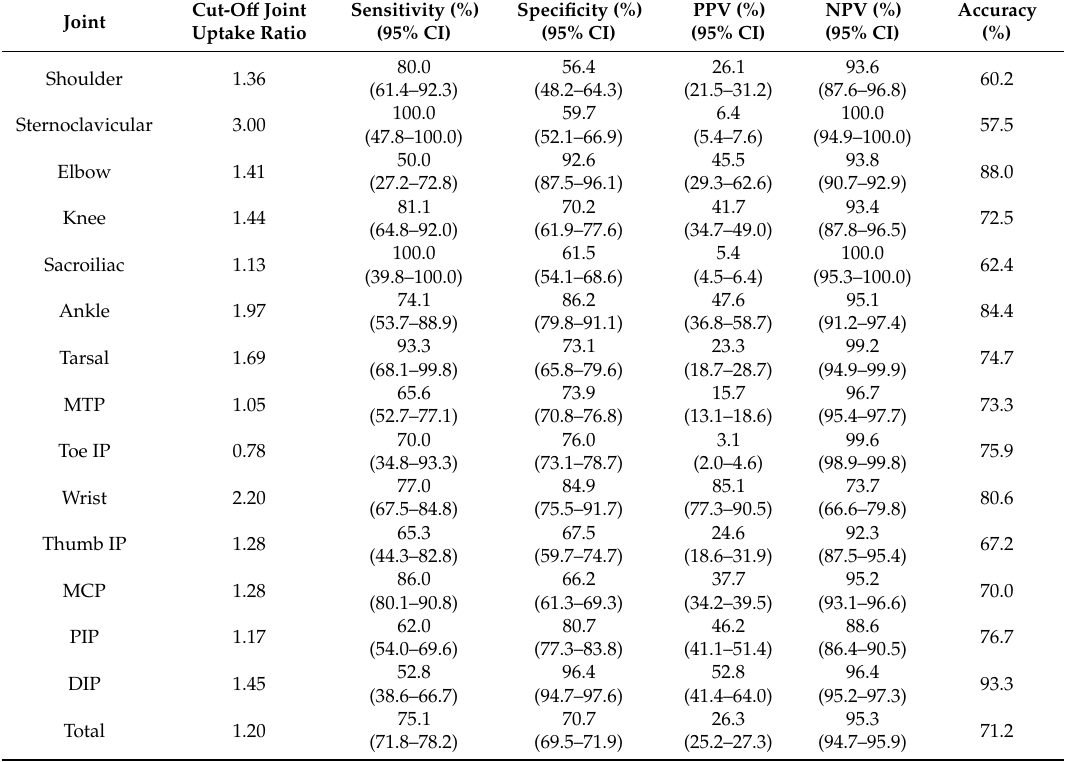
Table 3. The diagnostic ability of joint uptake ratio for detecting a ff ected